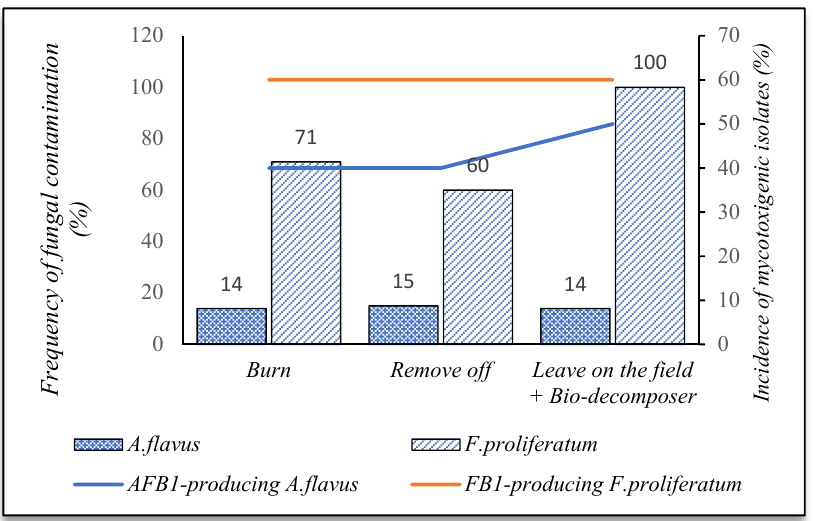
Figure 7. Incidence of fungal contamination and mycotoxigenic fungi in function of crop residue management practices.